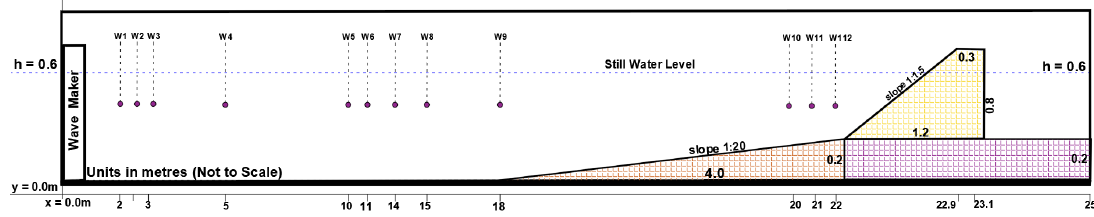
Figure 4. Layout of a 2-D numerical model (not to scale) for a waveheight extraction using the wave gauges near the wavemaker and the structure.